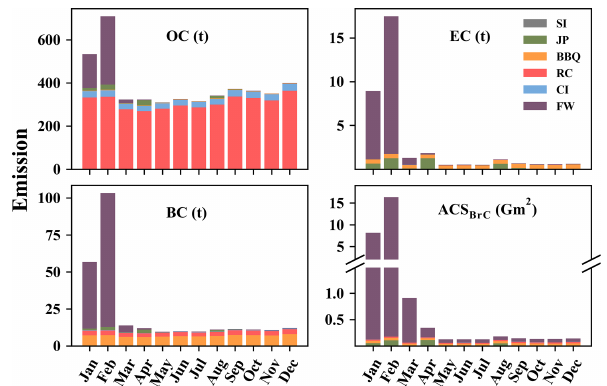
Figure 7. Average CA emissions during Chinese New Year’s Eve (CNE), the Chinese Spring Festival (CSF), the Spring Lantern Fes- tival (LF), the Qingming Festival (QF), and the Zhongyuan Festival (ZF) for the period from 2000 to 2018. AVE shows the average daily emissions for periods outside of the festivals mentioned